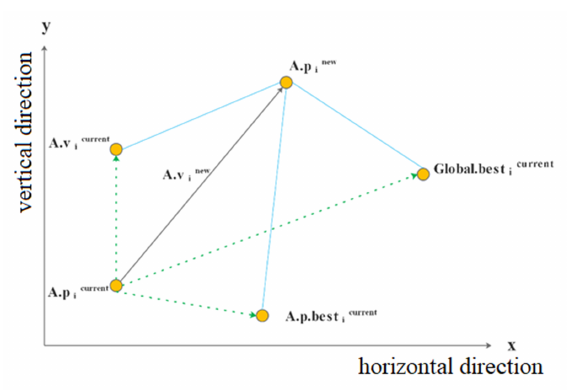
Fig. 1. The mechanism of the search algorithm for PSO (cid:16) (cid:17) = f N j The output layer structure has on neuron and is classi- fied as an operational layer. The activation function for this layer is a mostly pure